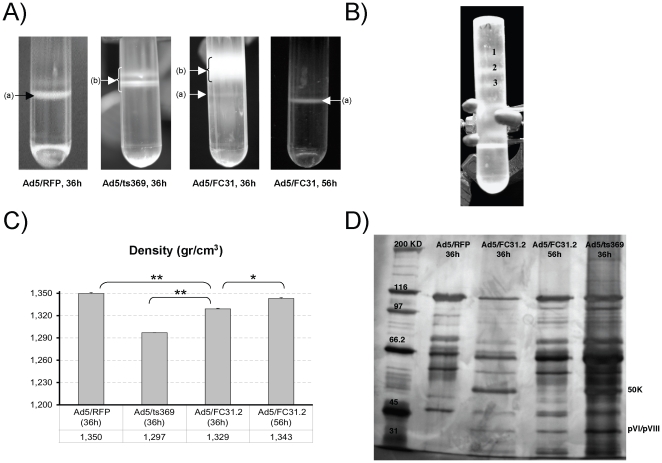
Results of first cesium chloride gradient (A).Shown are images for Ad5/RFP and Ad5/FC31.2 at 56 hpi and Ad5/FC31.2 at
36 hpi. Arrows indicate (a) mature particles, and (b) immature
particles. (B) Second cesium chloride gradient for Ad5/FC31.2 at 56 hpi,
1, 2 and 3 indicates three low density bands. (C) Density in
(g/cm3) of purified particles of Ad5/RFP, Ad5/ts369,
Ad5/FC31.2 at 36 hpi and Ad5/FC31.2 at 56 hpi. (D) Silver stained
polyacrylamide gel of CsCl purified particles of Ad5/ts369 and Ad5/RFP
at 36 hpi. and attB-Ad at 36 and 56 hpi. Asterisks
refers to statistical significance: * p<0,05; **
p<0,01.